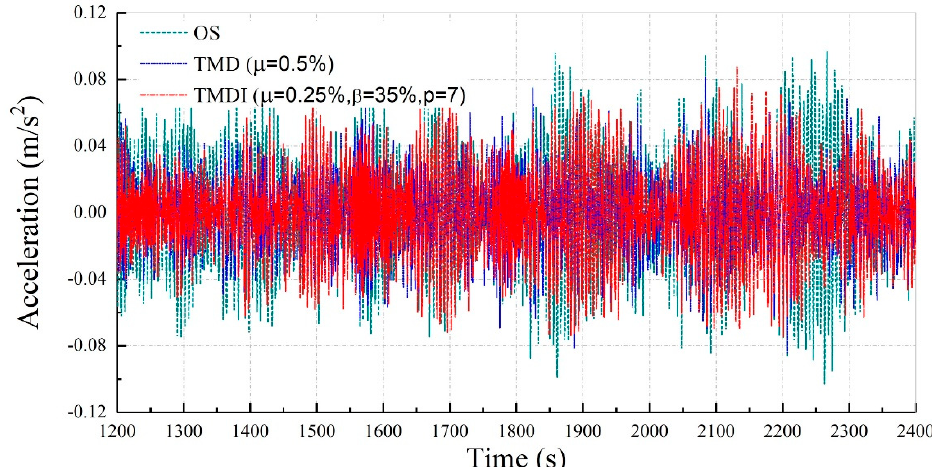
Figure 16. Time histories of acceleration at the 69th story along the x -axis corresponding to 90° wind direction.